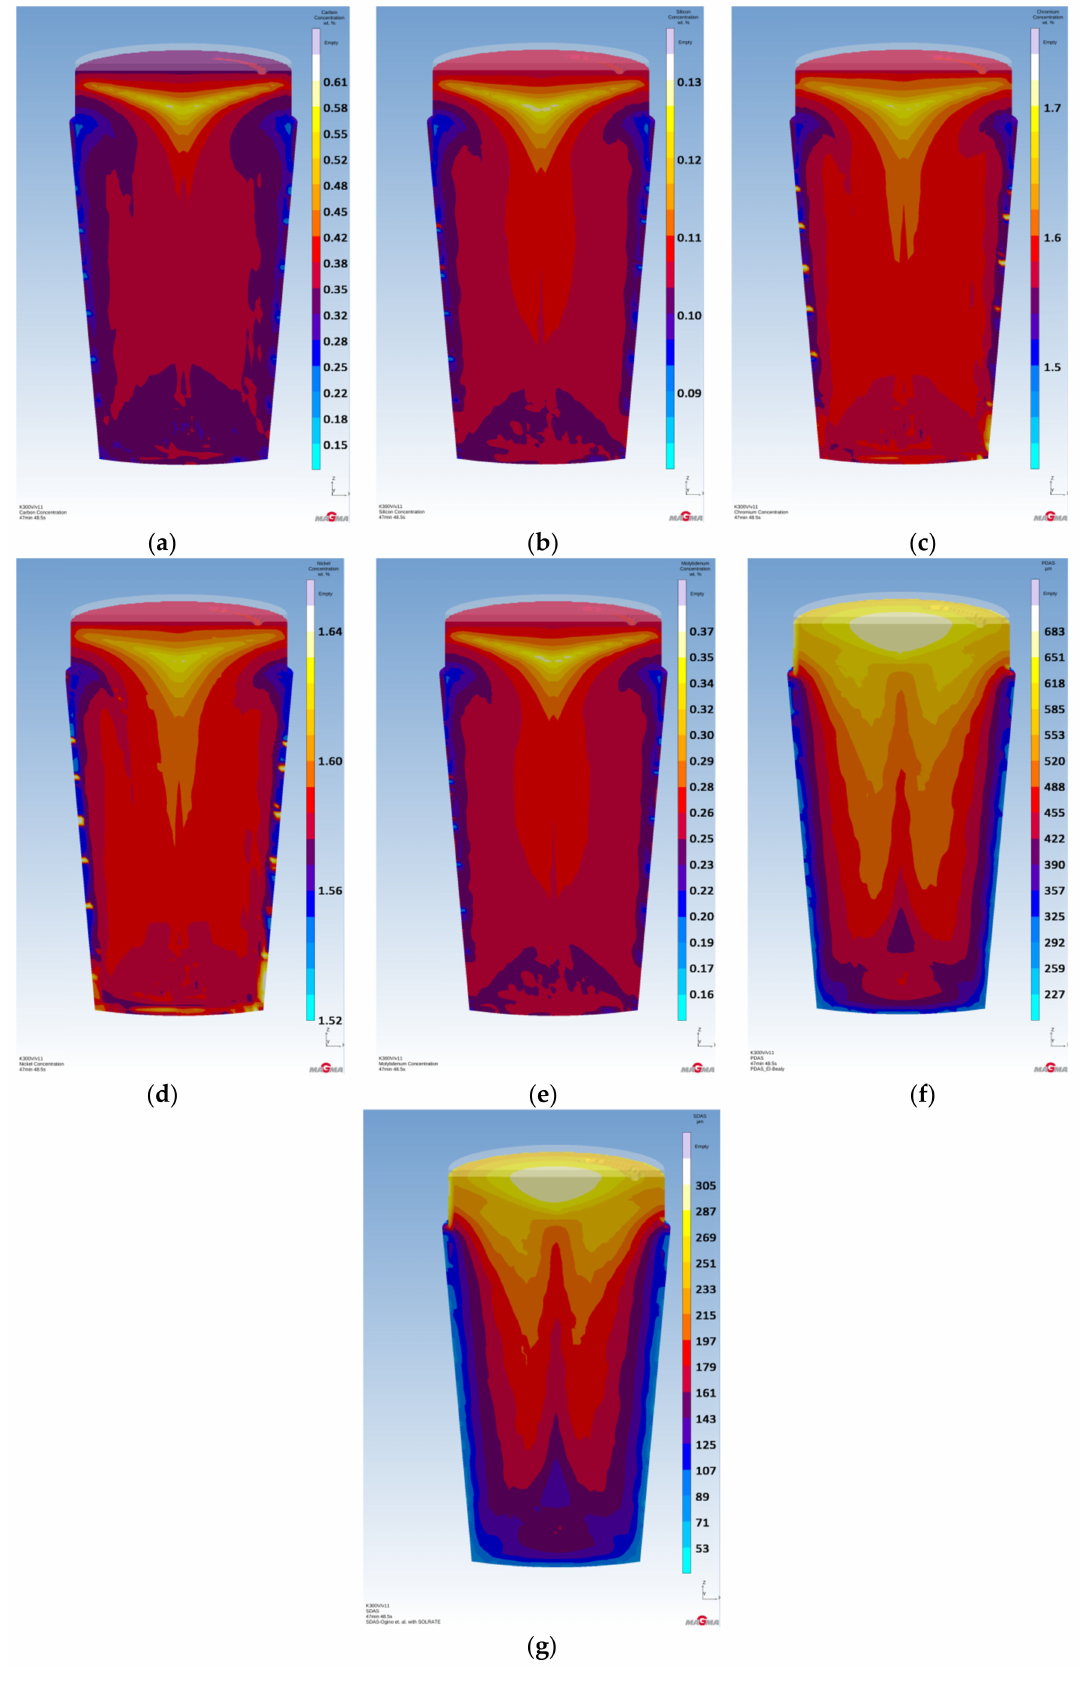
Figure 11. Element segregation, PDAS and SDAS: ( a ) [wt.% C]; ( b ) [wt.% Si]; ( c ) [wt.% Cr]; ( d ) [wt.% Ni]; ( e ) [wt.% Mo]; ( f ) PDAS; ( g )